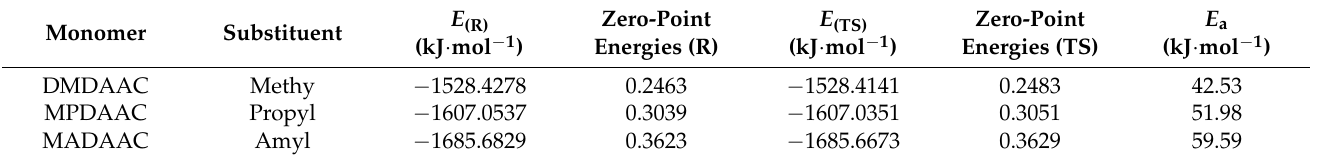
Figure 2. The optimized structures of methyl alkyl diallyl ammonium chloride monomers at the B3LYP/6-31G* level. Stable conformation of DMDAAC ( a ), stable conformation of MPDAAC ( b ), stable conformation of MADAAC ( c ), nitrogen atom (4), chlorine atom (25,26), carbon atom (1,2,3,5,6,7,8,9), and hydrogen atoms (remainder). Table 1. The total reactant energy E R , total energy E (TS) in transition state, and activation energy ( E a ) in transition state for the reaction of methyl alkyl diallyl ammonium chloride monomers with APS initiator